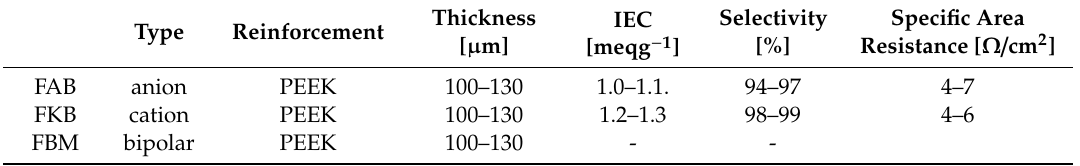
Table 2. Properties of membranes fumasep ® FAB, fumasep ® FBM with fumasep ® PEEK as reinforcement, provided by Fumatech